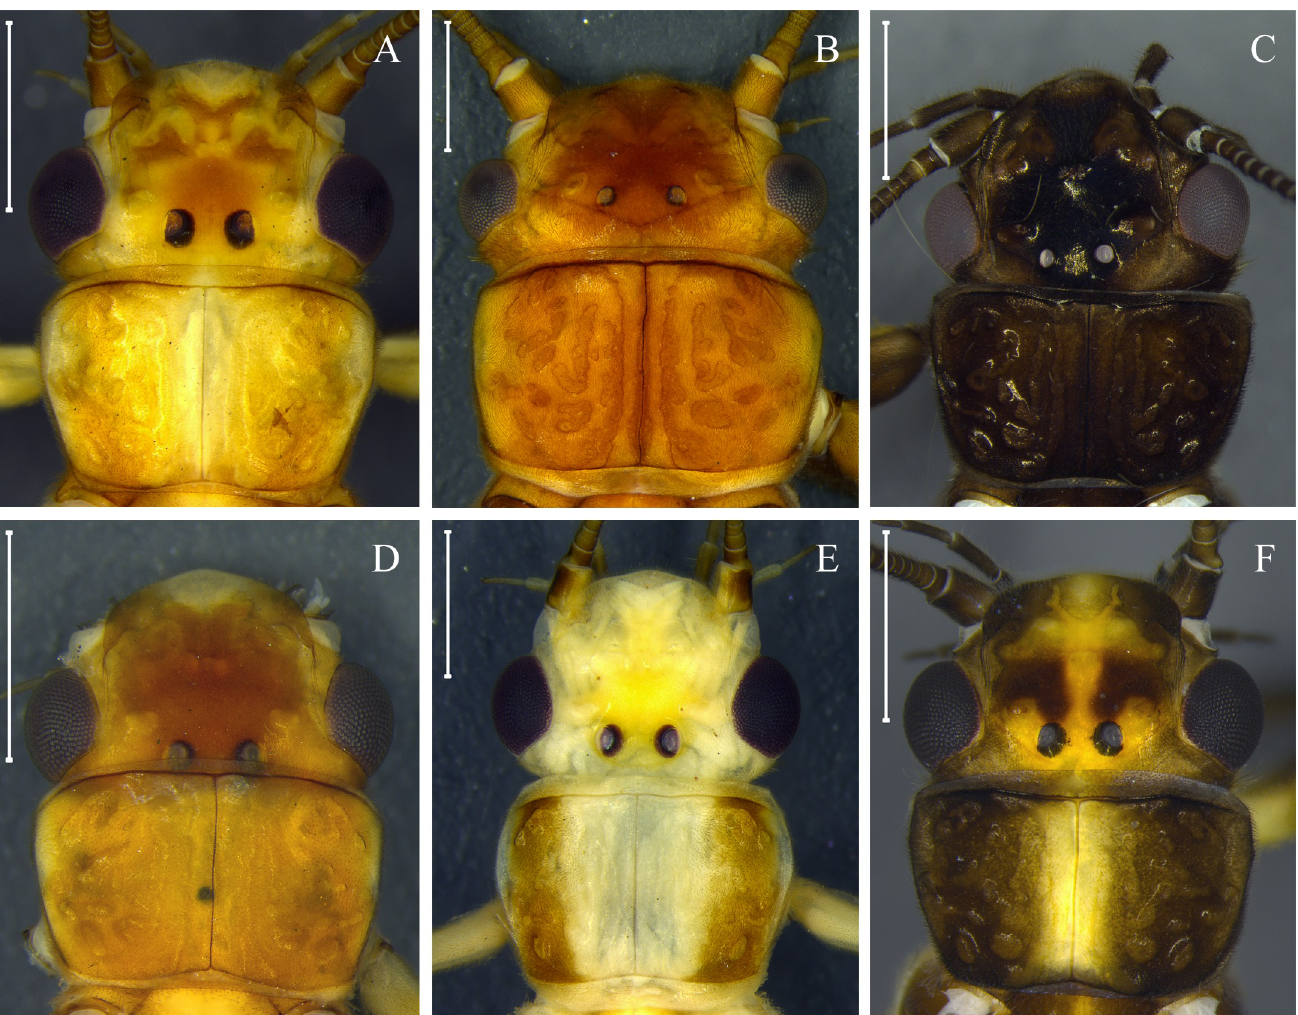
Fig 6. Anacroneuria species. Head and pronotum of A . boraceiensis adult male (A), A . iporanga adult male (B), A . itajaimirim adult male (C), A . polita adult male (D), A . subcostalis adult female (E), and A . tupi adult male (F). Scale: 1 mm.